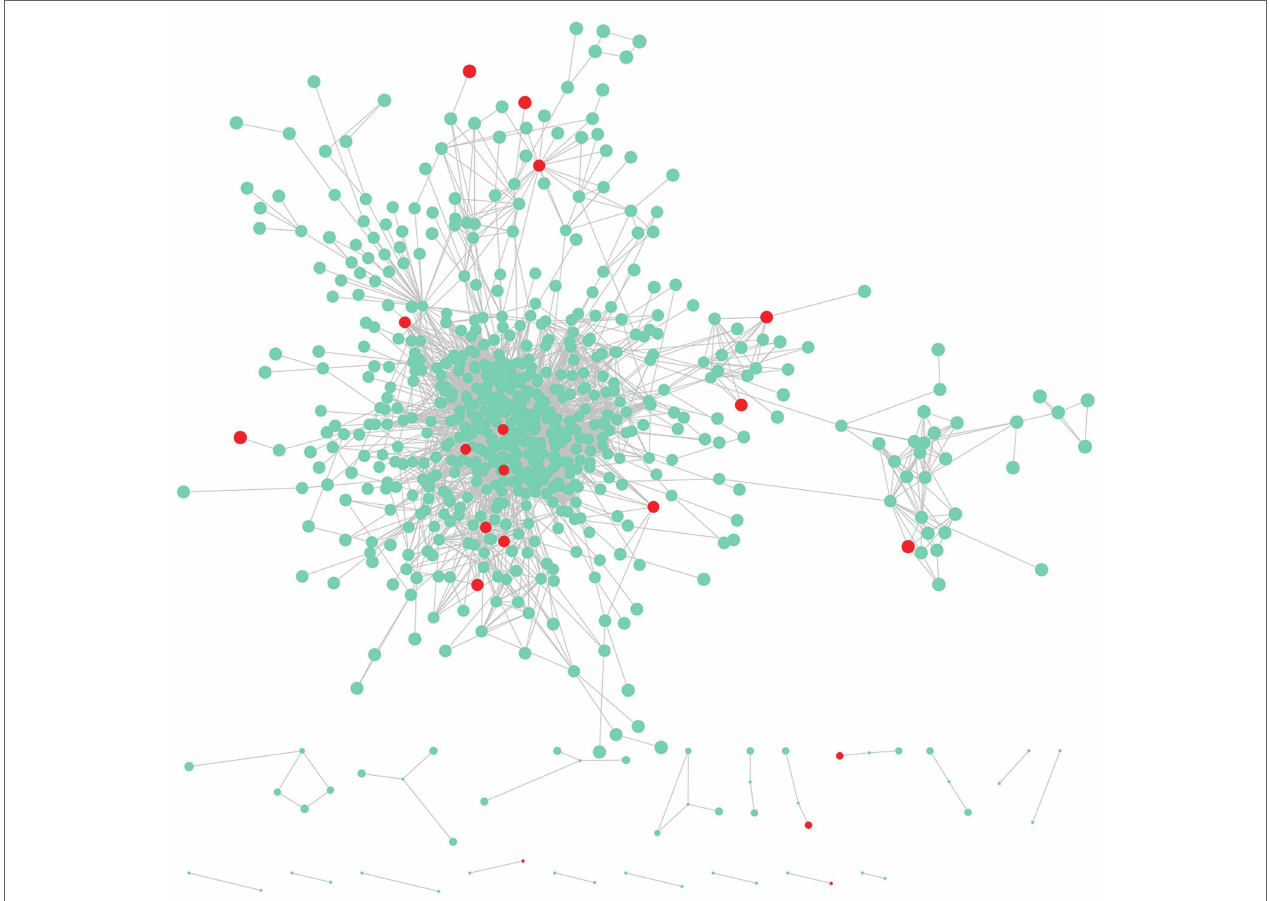
FIGURE 2 | Genes and protein–protein interaction (PPI) networks associated with the newly developed EST-SSR markers.